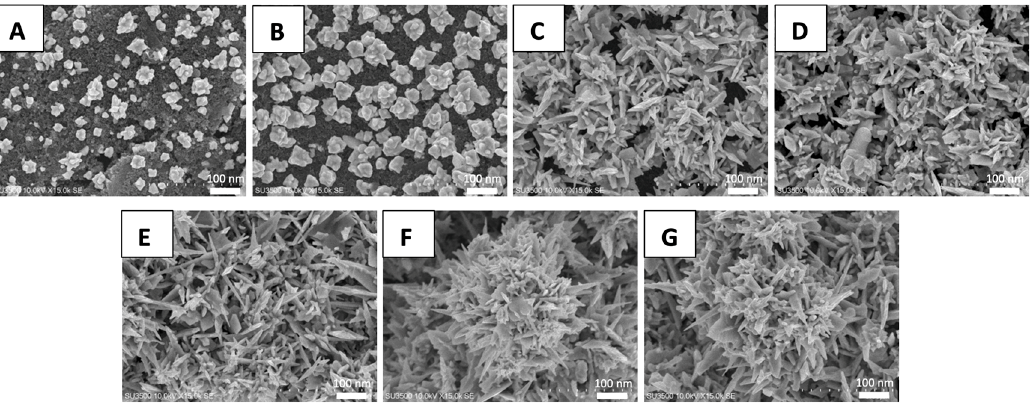
Figure 4. SEM images of electrodeposited Au nanostructure at various deposition times: ( A ) 60 s, ( B ) 300 s, ( C ) 600 s, ( D ) 900 s, ( E ) 1200 s, ( F ) 1500 s, and ( G ) 1800 s.